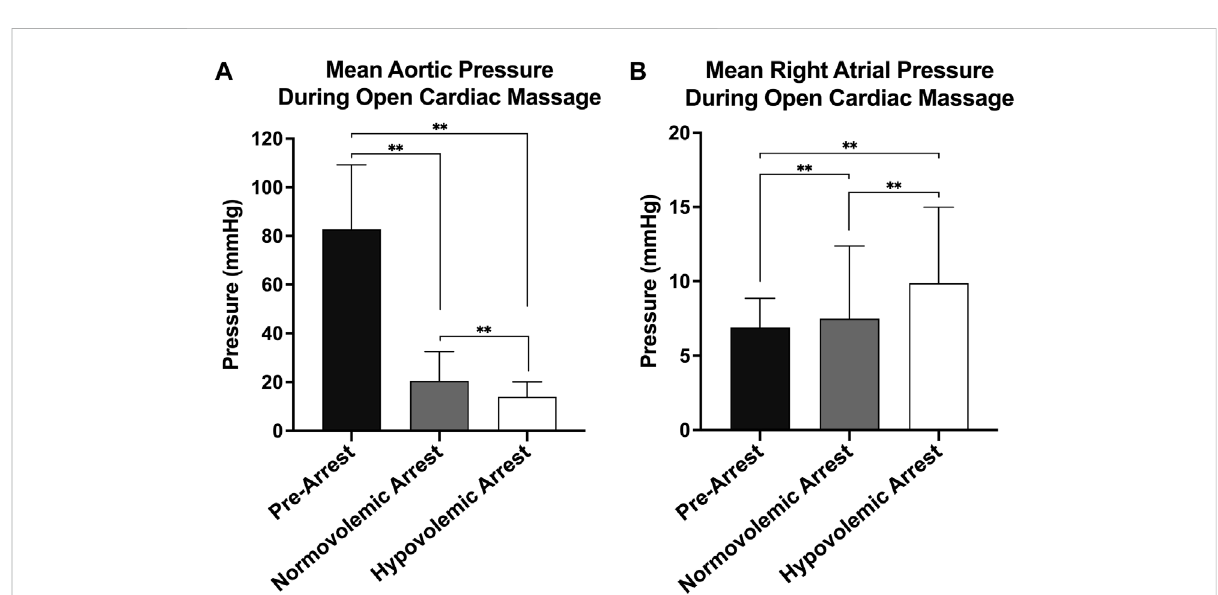
FIGURE 2 | Hemodynamics during open cardiac massage (OCM): (A) Mean aortic pressure with standard deviation of all three animal groups (pre-arrest, normovolemic arrest, and hypovolemic arrest), and (B) Mean right atrial (RA) pressure with standard deviation of all three animal groups. Statistical signi fi cance of p < 0.05 is denoted as * and p < 0.001 is denoted as